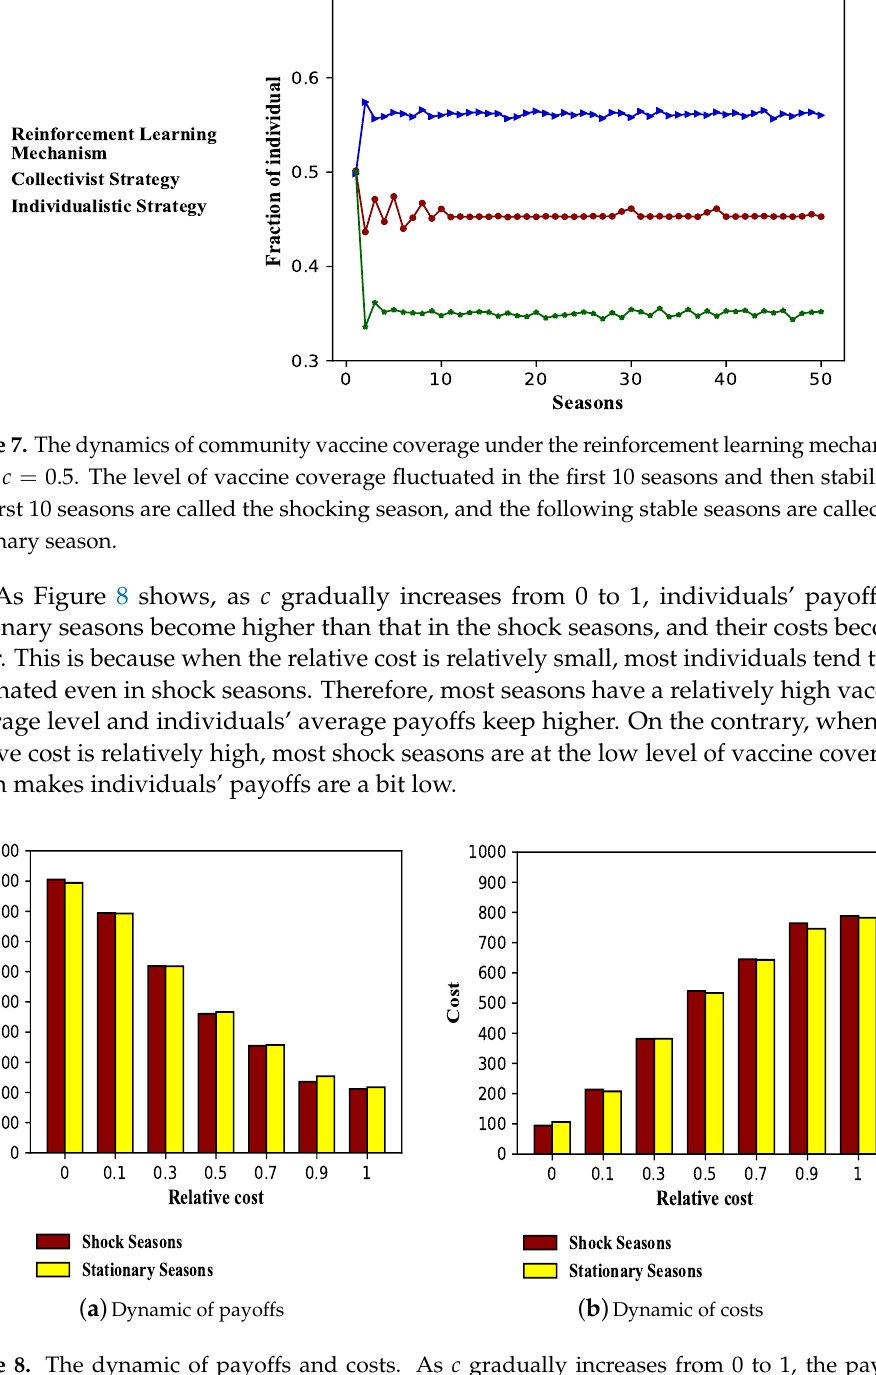
Figure 8. The dynamic of payoffs and costs. As c gradually increases from 0 to 1, the payoffs in the stationary states become gradually higher than the payoffs in the shock seasons, and the corresponding individuals’ costs become gradually